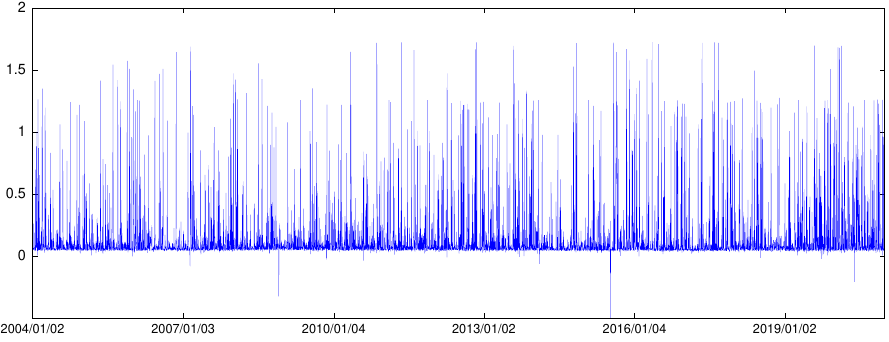
Figure 3. Posterior mean of ξ t of DIS from the RSV-DPM model. A comparison of the estimation results of the three semiparametric models shows that the RSV-DPM-ind model requires fewer mixtures to fit the asymmetric and leptokurtic properties of returns, whereas the SV-DPM model has to rely on additional mixtures. For example, the mixture for return distributions in the RSV-DPM-ind model contains on average 3.05, 2.89, 1.88 and 2.15 Gaussian distributions in the four applications, whereas the average numbers of clusters in the SV-DPM model are 5.51, 3.56, 8.34, and 3.59. As shown in the top panel of Figure 4, the latent volatility estimates E ( h t | y 1: T ) of the RSV model is noisier than that of the RSV-DPM model, which is consistent with the weaker volatility persistence and higher logRV volatility shown in Table 2. Such a result indicates that without non-Gaussian innovation terms, volatility fluctuates more to accommodate the return distribution, which sacrifices the time-dependent nature of volatility. The bottom panel of Figure 4 shows that the RSV-DPM model captures similar time-series volatility dynamics as the SV-DPM